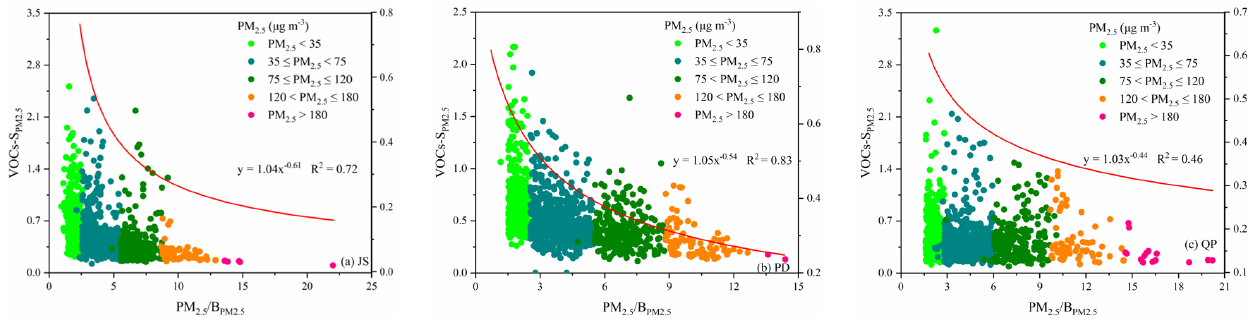
at the different levels of PM 2 . 5 at the JS, PD and QP 2 . 5